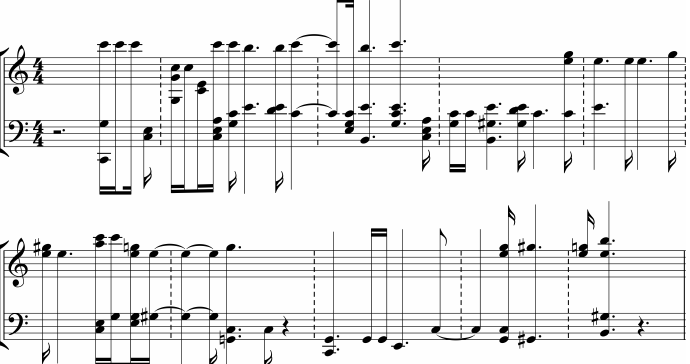
Figure 31. The resulting rhythmic sequence of